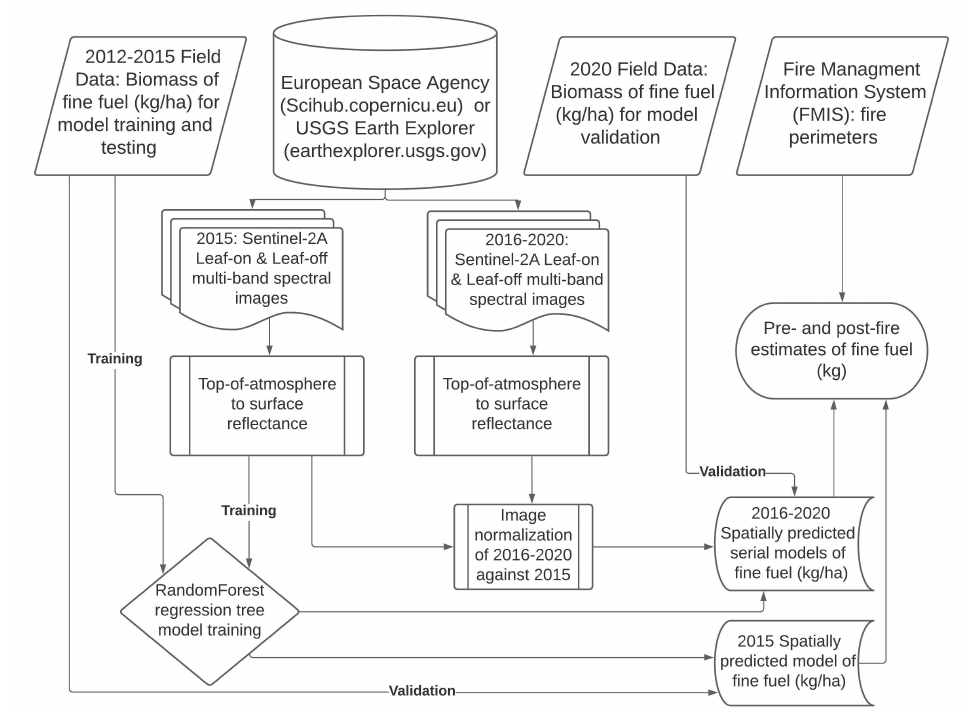
Figure A1. Analysis flowchart showing input data and processing steps for estimating changes of fine-fuels (kg/ha) over time in relation to prescribed fire and wildfire.